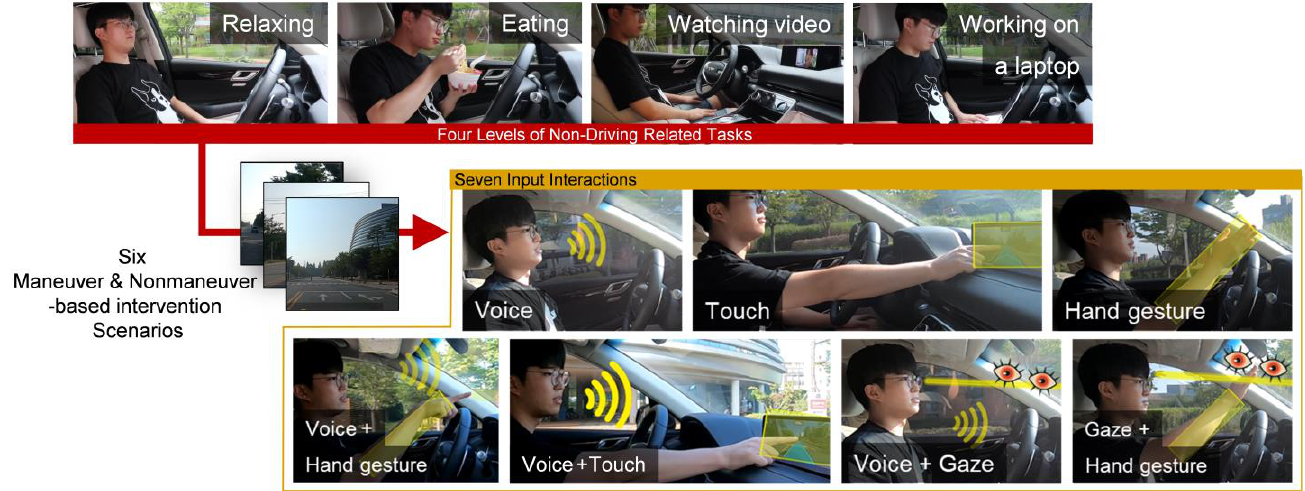
Figure 1. Which input interaction is most naturalistic? We analyzed preferences of seven input interactions associated with the proposed non-driving related tasks and intervention scenarios.